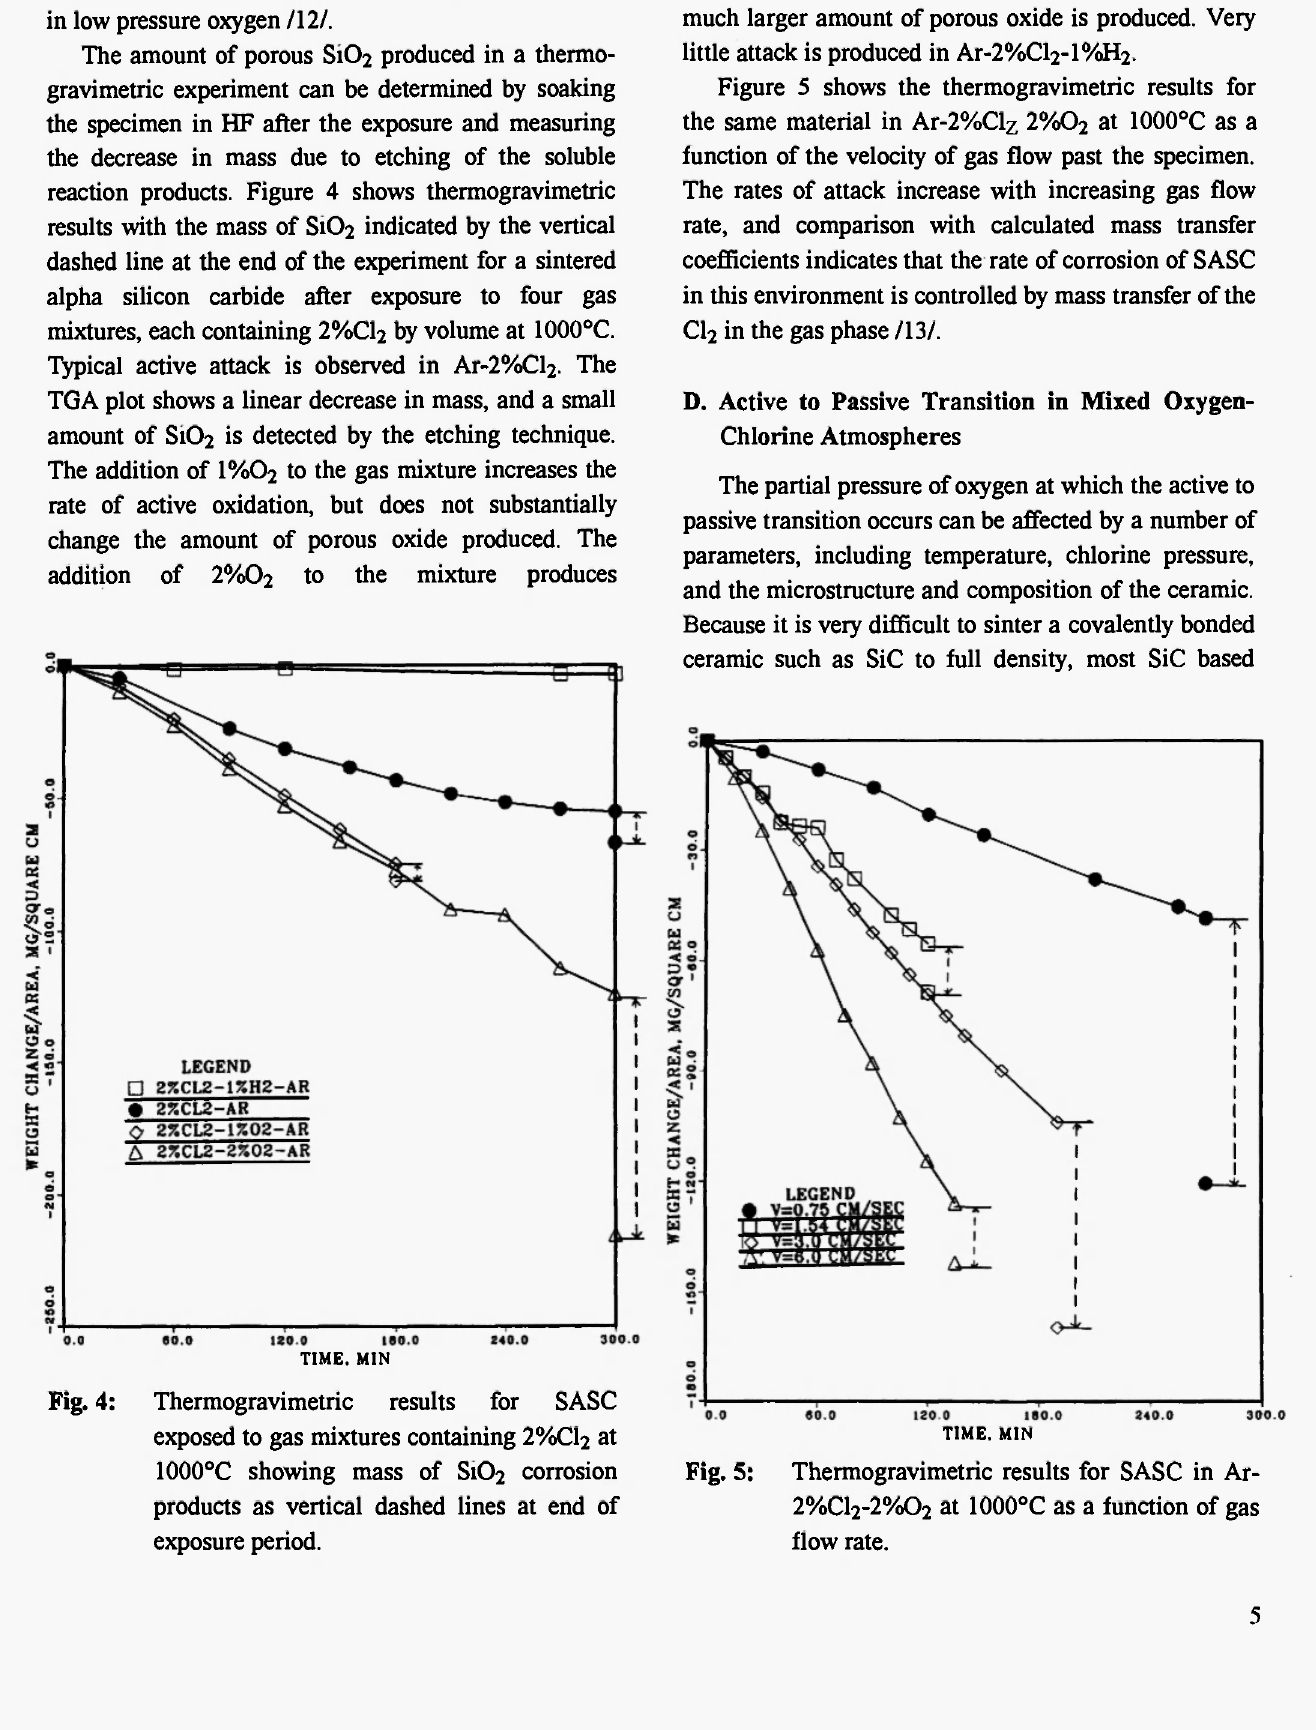
Fig. 5: Thermogravimetric results for SASC in Ar- 2%α -2%0 at 1000°C as a function of gas 2 2 flow